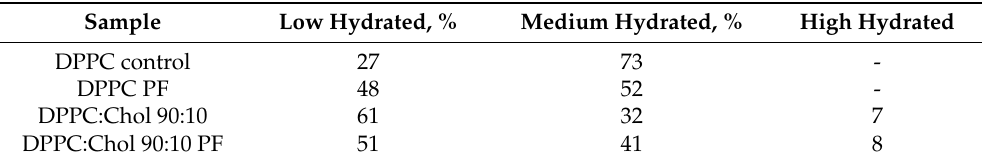
Table 4. Integral share of carbonyl groups components. 0.02 M sodium phosphate-buffered